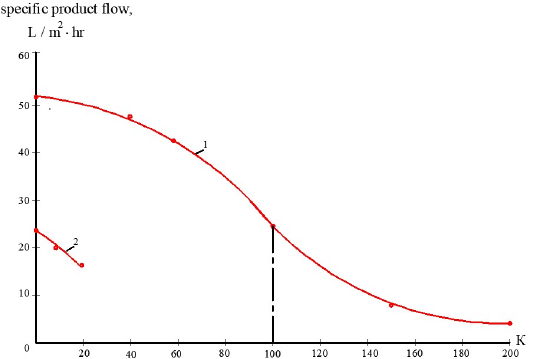
Figure 11. Reduction in nanofiltration and reverse osmosis membrane specific product flow as a function of K in different experiments: 1—reduction in nanofiltration membrane flux in the first series when natural water volume was reduced by 200 times; 2—reduction in reverse osmosis mem ‐ brane flux in the third series when double ‐ stage treatment scheme was applied to treat reject efflu ‐ ent.